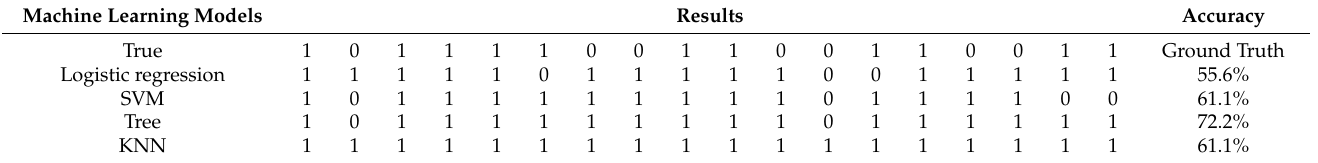
Table 4. Outcome of the MR radiomics prediction model in the external validation group ( n =